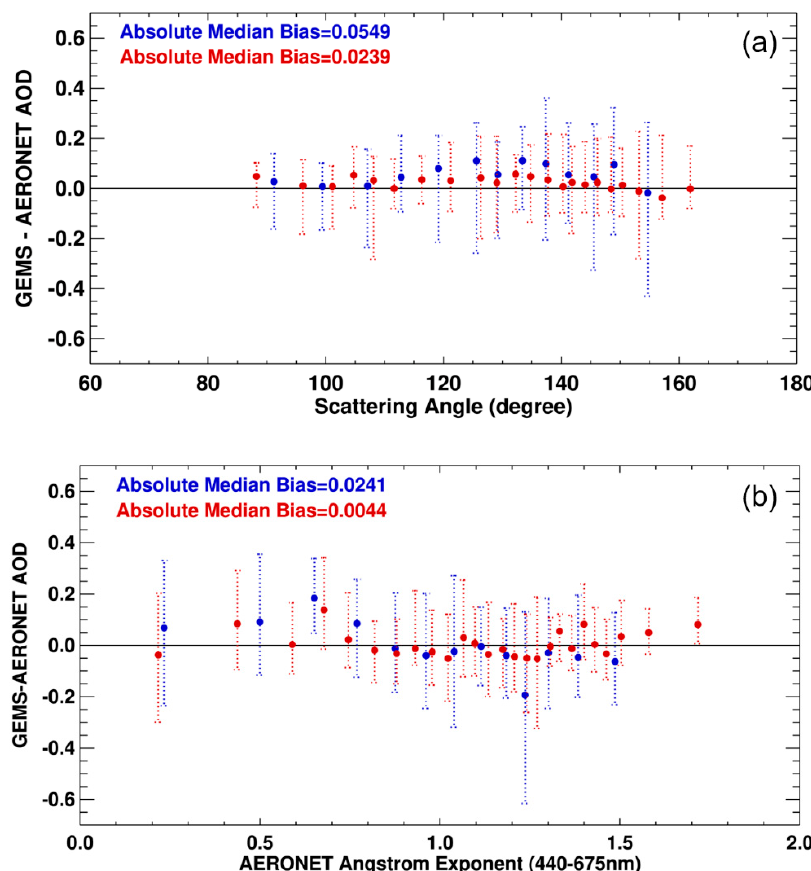
Figure 12. ( a ) The bias of GEMS AOD with respect to scattering angle. ( b ) The bias of GEMS AOD with respect to collocated AERONET Ångström exponent (440–675 nm). Blue and red refer to before and after aerosol fusion, respectively. The absolute median bias (AMB) was calculated for the total collocated blue and red points. Circles and bars represent median and SD values for 40 collocated points of GEMS and AERONET data.